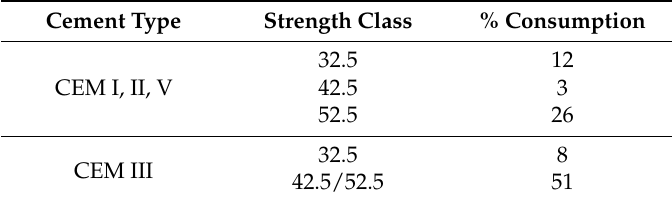
Table 7. Percentage consumption of various classes of cement in Belgium in 2015 cf.